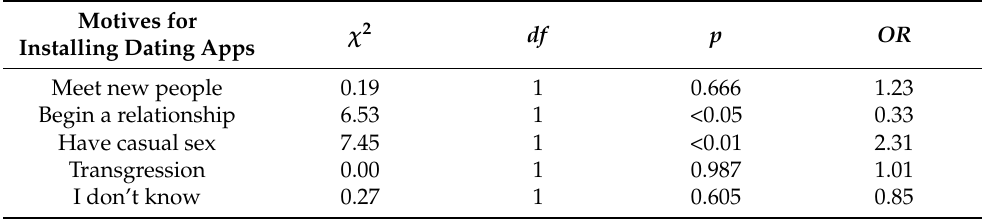
Table 5. Results from chi-squared analysis investigating the association between drinking alcohol regularly and motives for installing dating apps. Note that when applying the Bonferroni correction, the significance level is set at